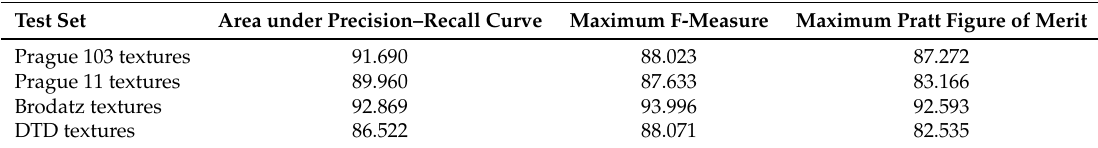
Figure 13. Pratt Figure of Merit curves for the four different test sets. Table 3. Area under mean precision–recall curve, maximum mean F-measures, and maximum mean Pratt Figure of Merit. The values are expressed as percentage